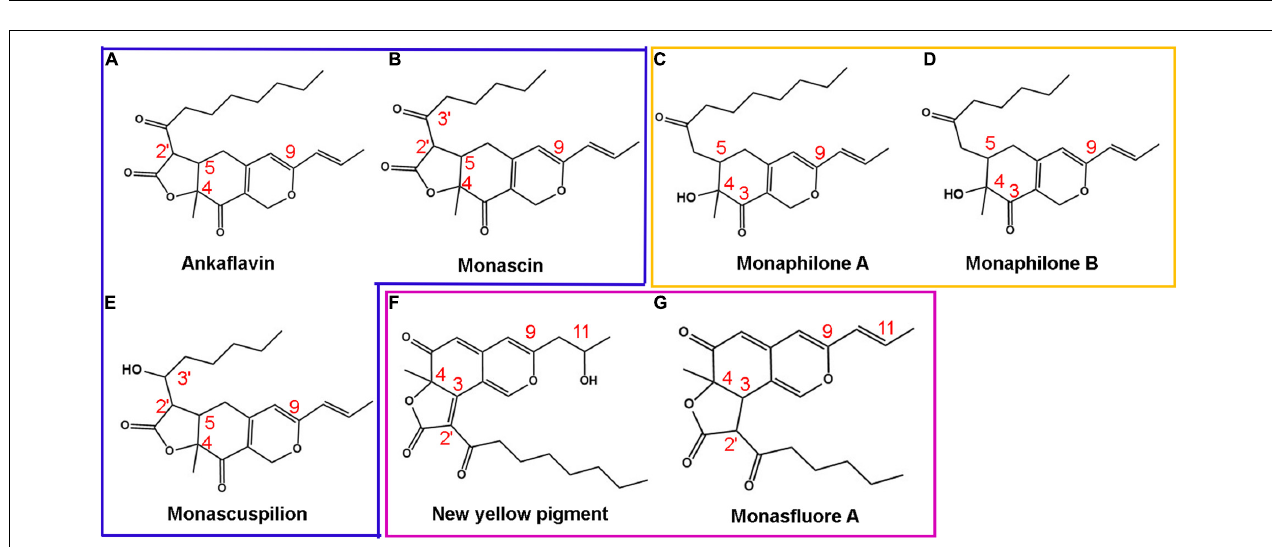
FIGURE 9 | Structures of Monascus yellow pigments. (A) ankaflavin, (B) monascin, (C) monaphilone A, (D) monaphilone B, (E) monascuspilion, (F) new yellow pigment, and (G) monasfluore A. Similar structures are represented by different colored boxes. Monascus yellow pigments (MYPs) in the blue box have a C5-C2 (cid:48) linear tricyclic carbon skeleton, MYPs in the orange box do not have a lactone ring, and MYPs in the purple box have a C3-C2 (cid:48) angular tricyclic carbon skeleton.